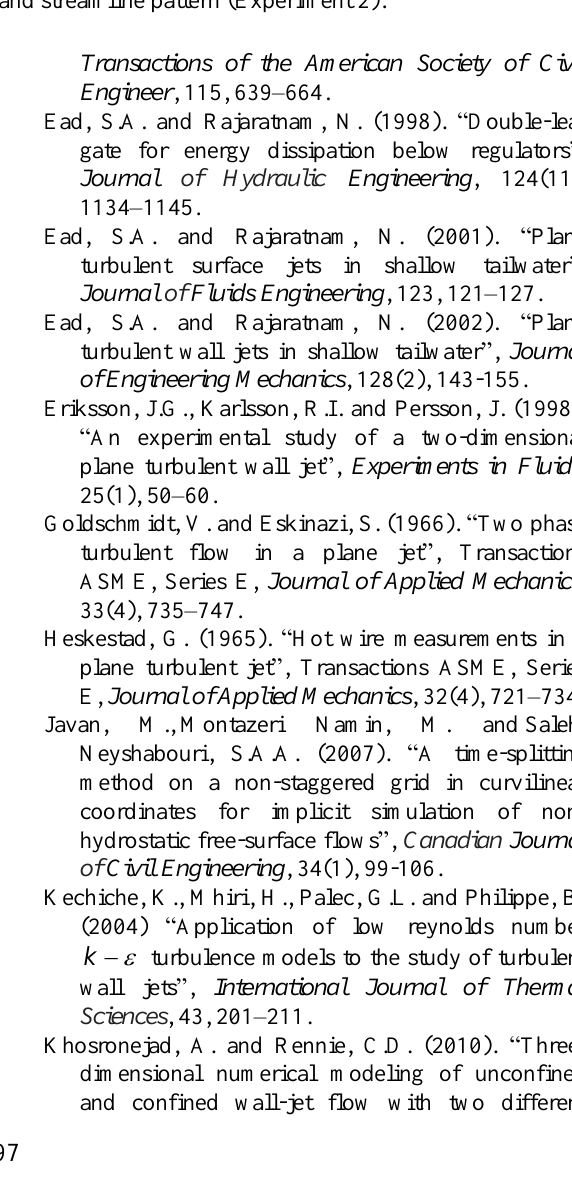
Fig. 6. Simulated free surface profiles and streamline pattern (Experiment